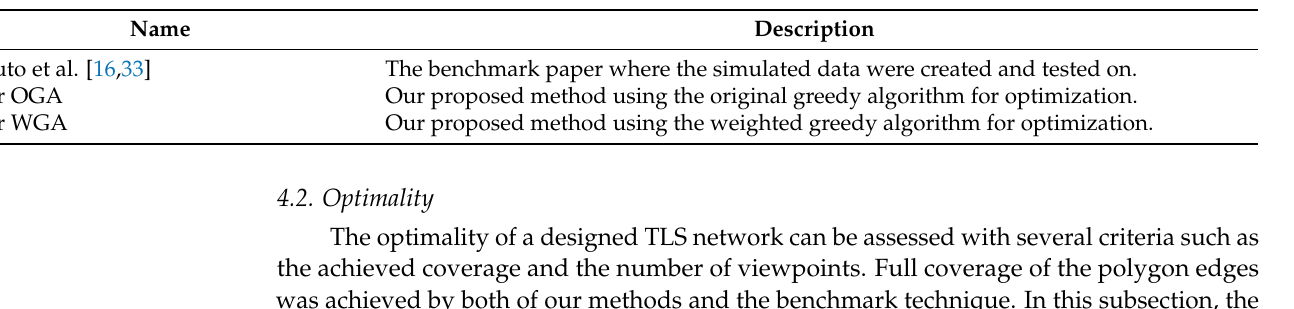
Table 3. Methods for comparison.